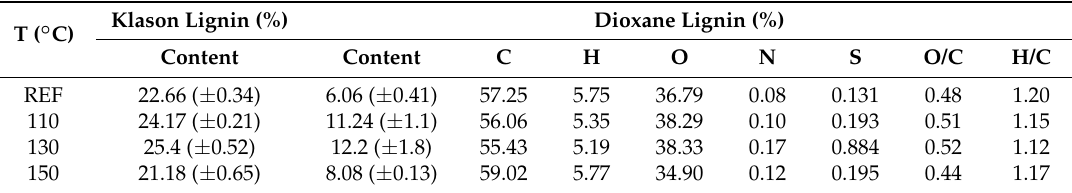
Table 1. Chemical composition of lignin during the heat treatment.